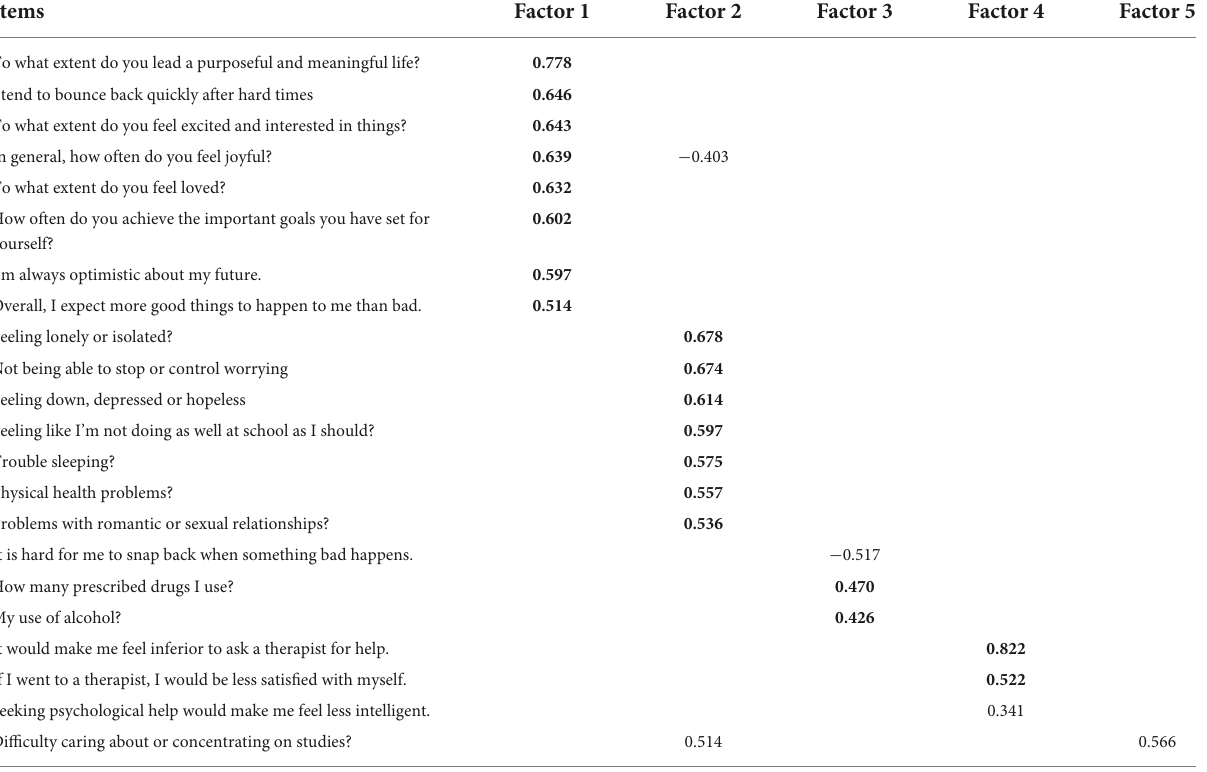
TABLE 2 Exploratory factor analysis (EFA) results of the student veterans with